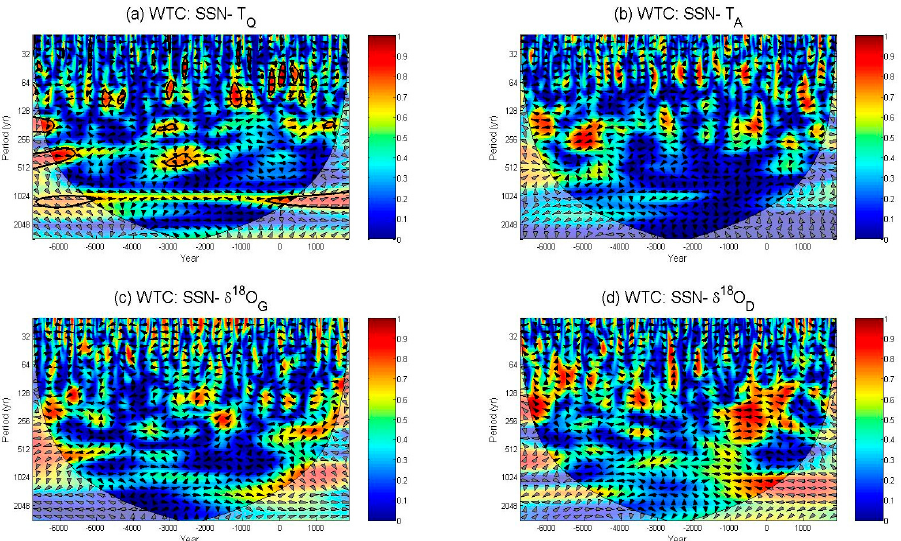
Figure 2. Cross-wavelet analyses between SSN and climate indices during the study time (BC 6755–AD 1885). The red regions enclosed by thick black lines denote their confidence levels higher than 95% against red noise. The light black curve denotes the ‘cone of influence’ (COI) outside which the edge effects might distort the picture. Black arrows represent phase angles of two records in the cross-wavelet analyses.